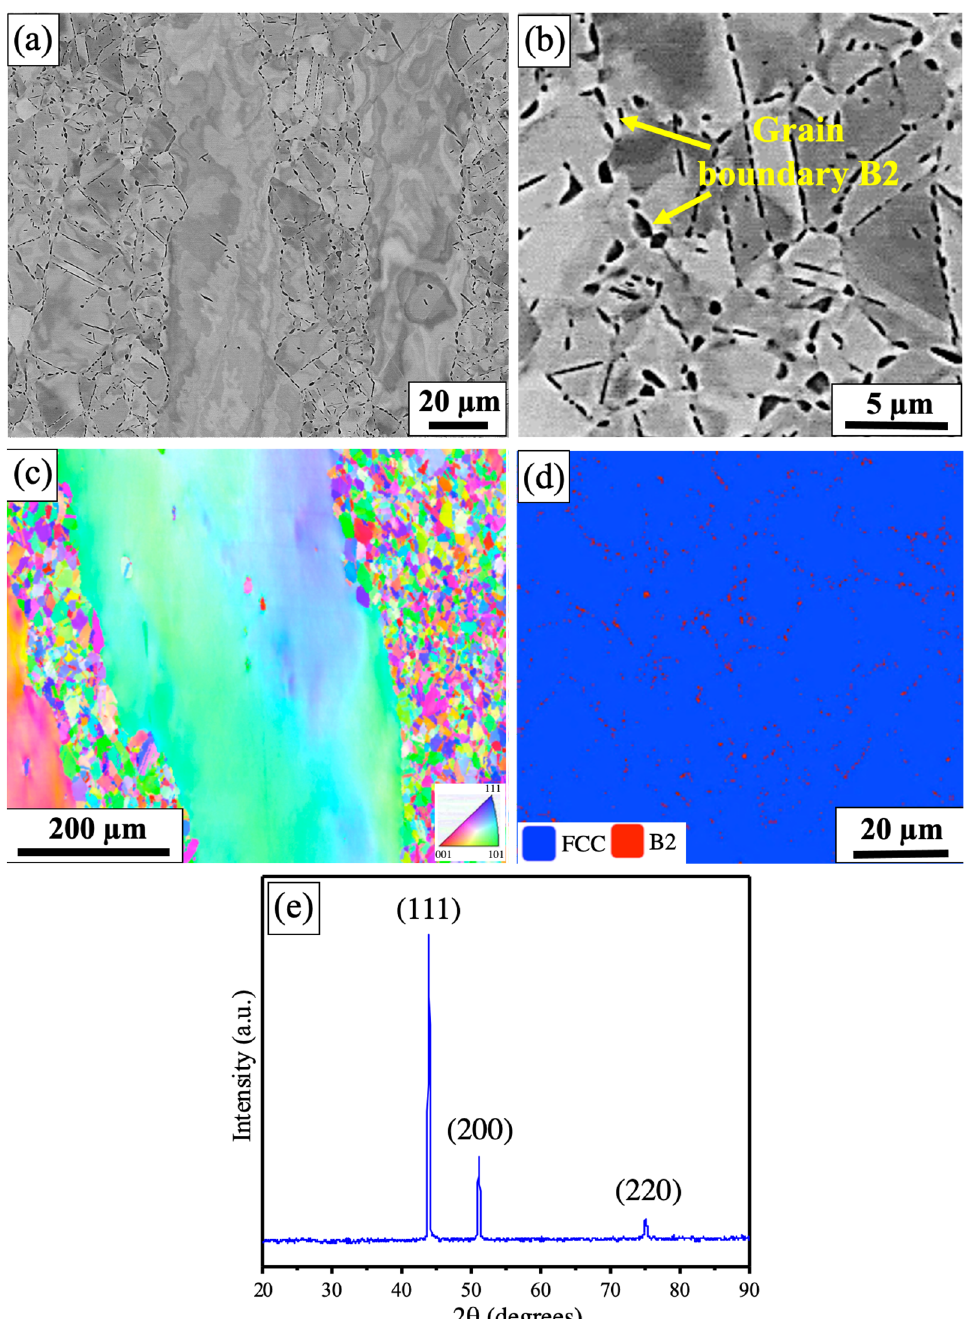
Figure 1. Microstructural characterization of thermomechanically processed Al 0.3 CoCrFeNi high entropy alloy: ( a ) backscattered electron (BSE) microscopy image showing bimodal microstructure of elongated strained grains and recrystallized fine grains; ( b ) A high magnification BSE image showing B2 precipitates decorating the grain boundaries; ( c ) EBSD inverse pole figure showing bimodal grains with recrystallized fine grains of average size ~ 15 µm; ( d ) A high magnification EBSD phase map showing FCC and B2 phases in blue and red colors, respectively; ( e ) X-ray diffraction analysis showing FCC crystal